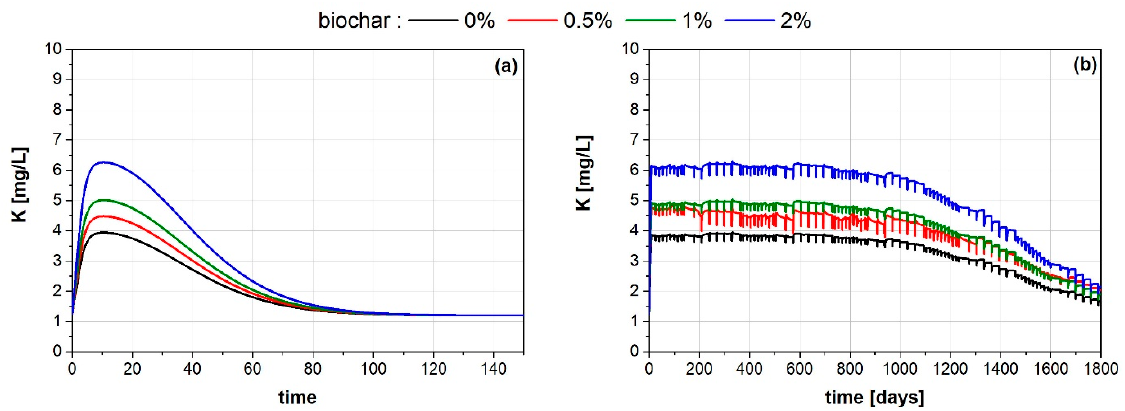
Figure 6. Potassium release under ( a ) saturated flow conditions and ( b ) unsaturated flow conditions, for the K.E. approach and different soil/biochar mixtures.